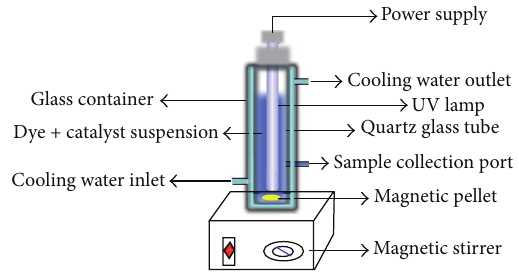
Figure 1: The schematic diagram of the photocatalytic